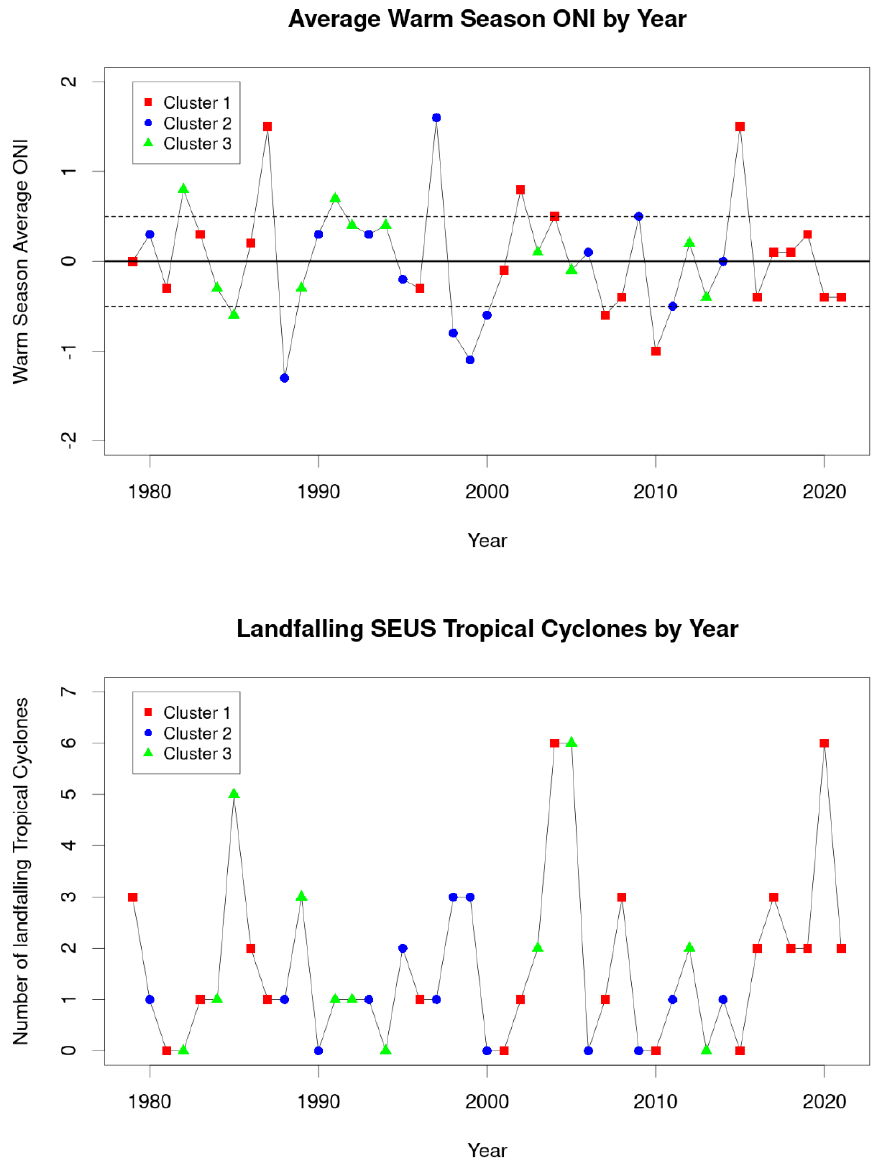
Figure 10. Oceanic Niño Index by year (top panel) and SEUS landfalling tropical cyclone frequency by year (bottom panel) for each cluster. Table 3. Bootstrap confidence intervals of 95% and medians for average annual SEUS landfalling tropical cyclones, broken down by cluster. If the median bootstrap replicate falls outside the interval